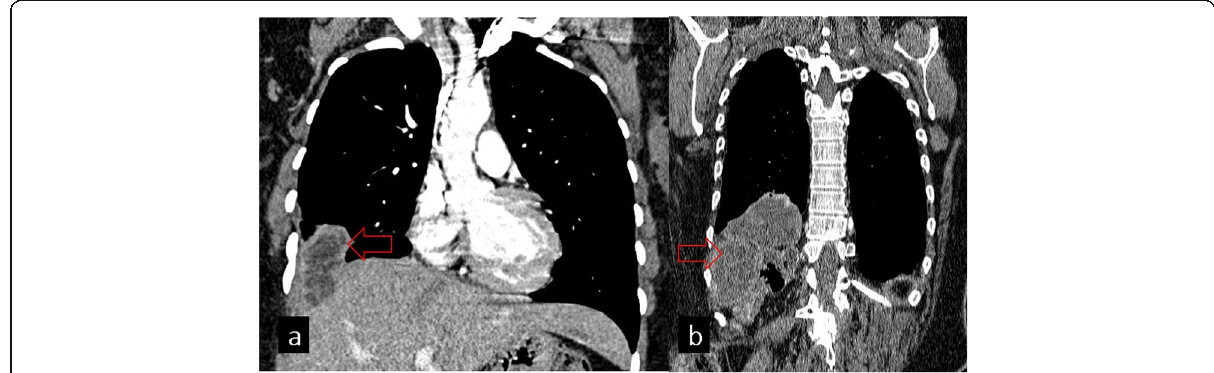
Fig. 14 Chest CT images on the coronal plane show transdiaphragmatic migration of hydatid cysts in different patients ( a , b , red arrows). Diaphragmatic discontinuation can be